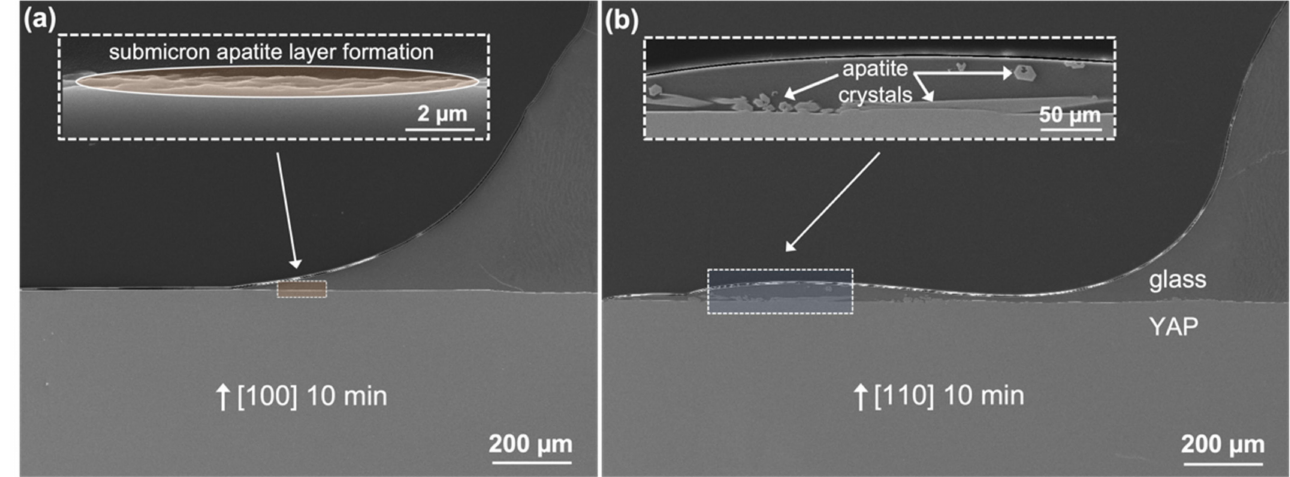
Figure 8. SE micrographs showing CMAS wetting and the edge of the reaction region after 10 min at 1350 ◦ C. The ( a ) (100) YAP substrate is representative of what is seen in the (001) YAP substrate not shown. Similarly, the (110) YAP substrate in ( b ) is representative of that seen in the (101) YAP substrate not shown. Insets show higher magnification images at the YAP/CMAS interfaces indicated.